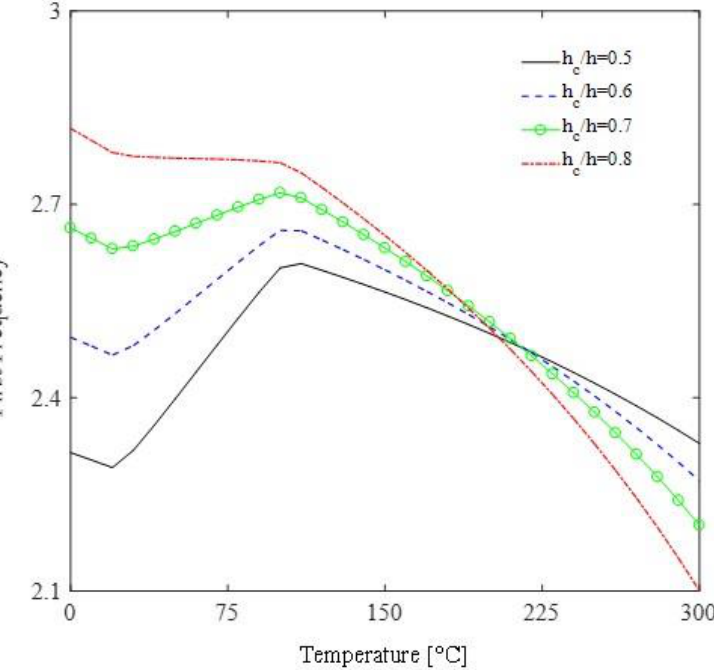
ℎ⁄ = 0.5 and 𝜀 = 0.4 , ℎ = 2% ). 𝑆𝑀𝐴 𝑐 0